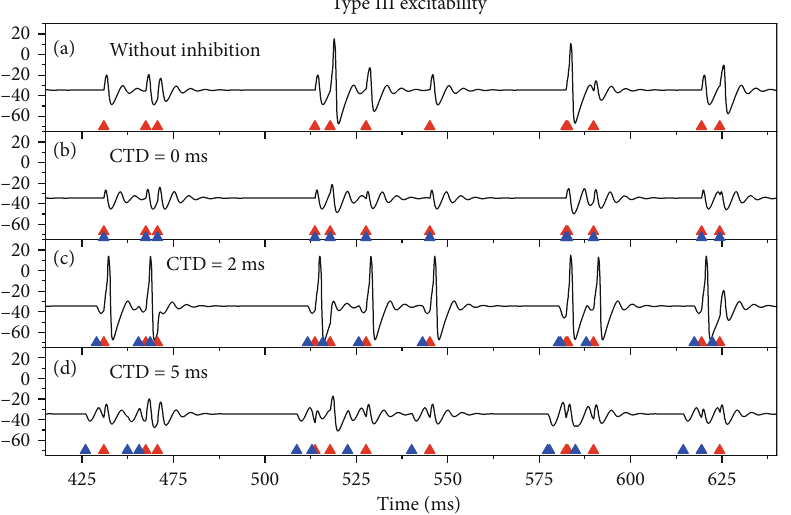
= 2 : 5mS/cm 2 ). (a) Some random ex